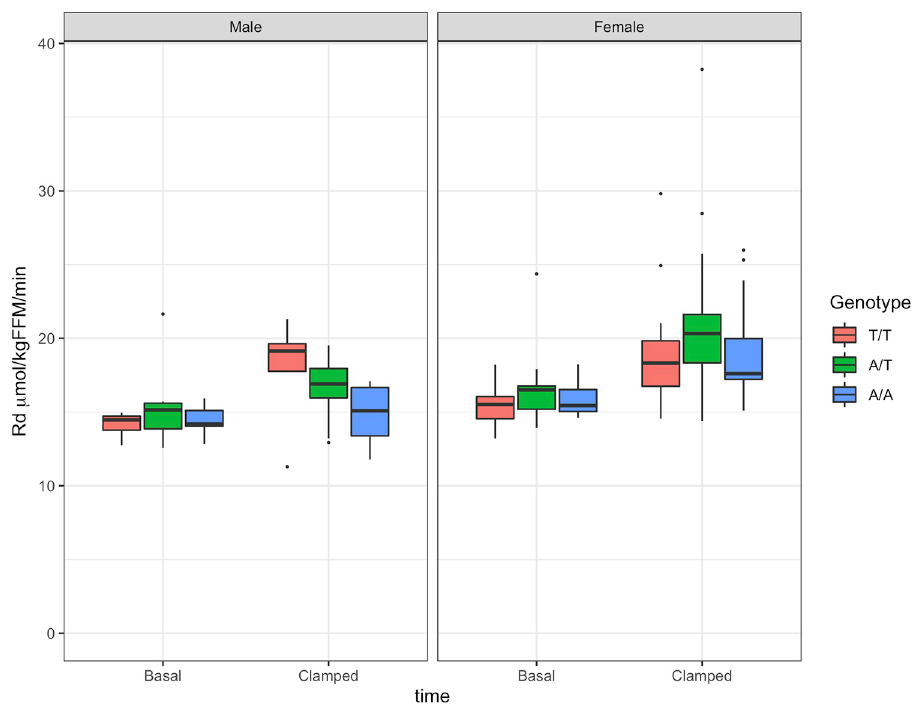
Fig 5. Glucose uptake (Rd) by sex and genotype. Glucose Rd at basal time and in response to insulin infusion (0.3 mU � kg -1 � min -1 ). Boxplots for males in left panel and for females in right panel.